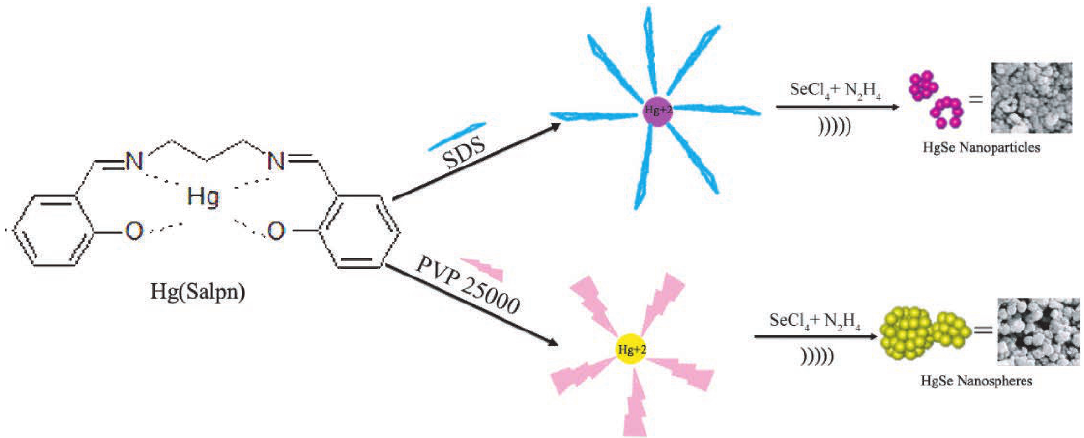
Scheme 1. Schematic diagram illustrating formation of the HgSe nanoparticles. Sample no.